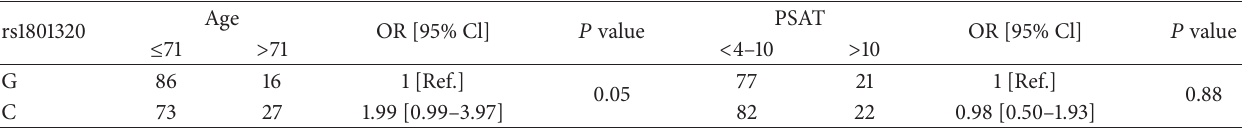
Table 6: Relationship between C allele for the RAD51 gene rs1801320 polymorphism and patient’s age and PSAT